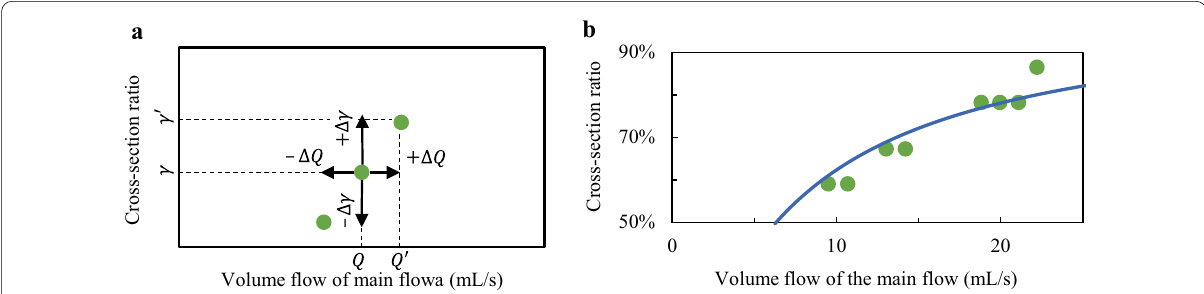
Fig. 7 The relation between the main flow rate and the cross-section ratio. a Schematic relation. b Comparison between the experimental result and the solution of the pressure